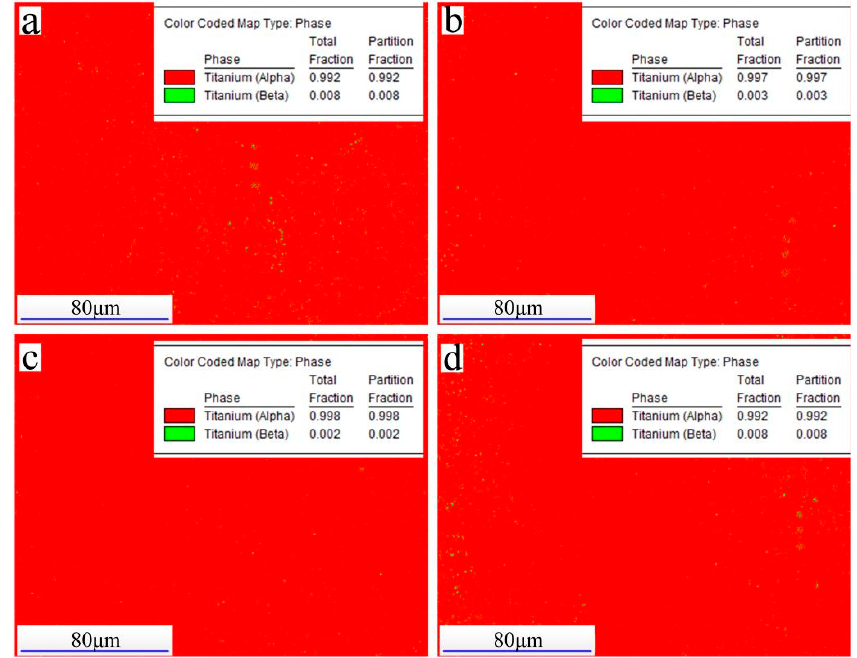
Figure 6. Phase distribution of titanium alloy DED-AAM component with the wire feeding speed of 7 m/min: ( a ) I M = 0 A, ( b ) I M = 1 A, ( c ) I M = 2 A, ( d ) I M = 3